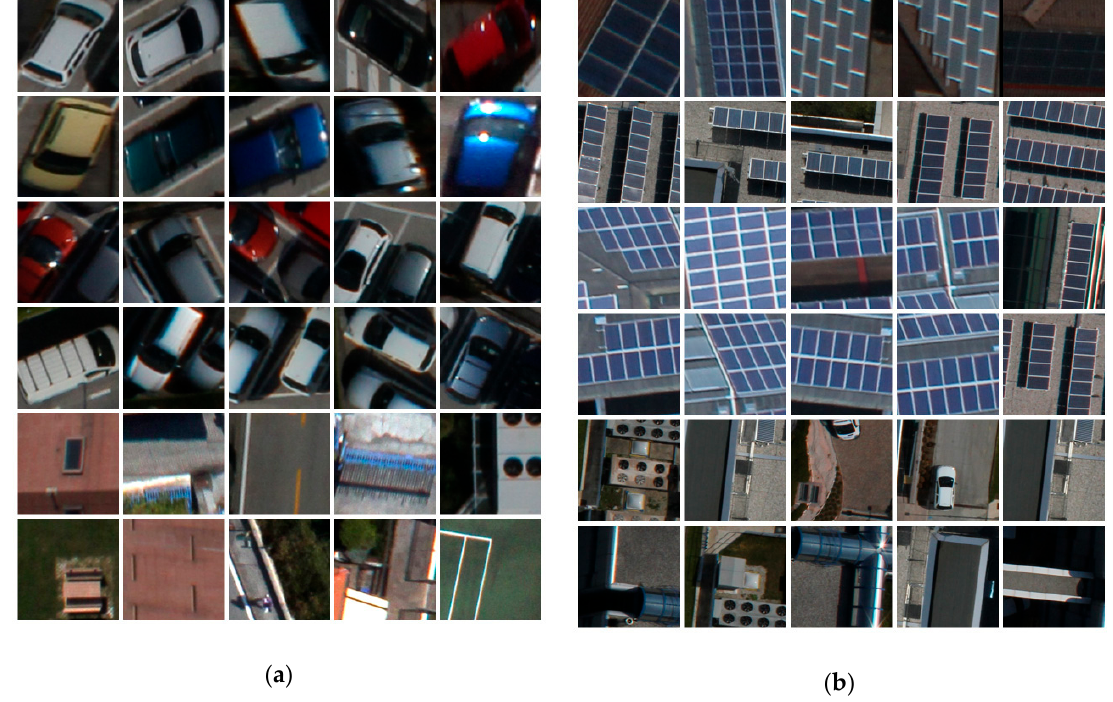
Figure 2. Examples of the images: ( a ) the car dataset, ( b ) the solar panel dataset. First four rows depict images that include objects of interest (car or solar panel), while last two rows show the images that do not contain them.